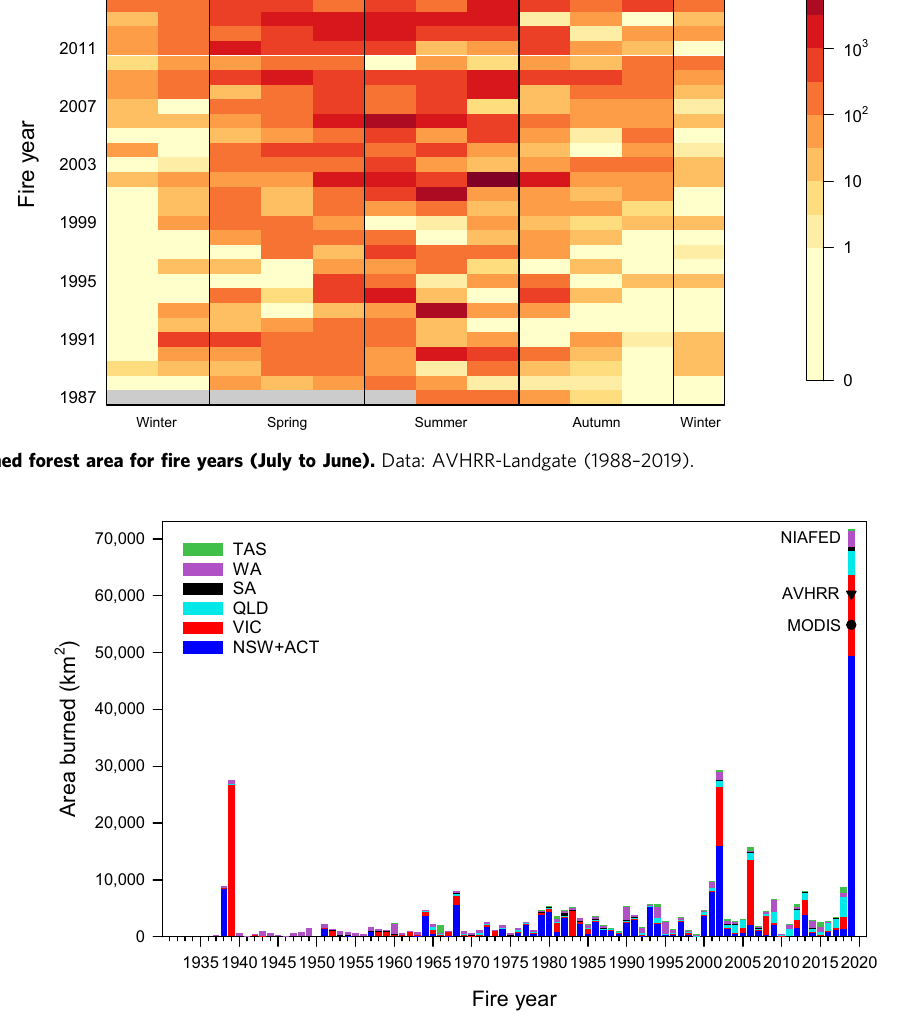
Fig. 3 Wild fi re burned area by states and territory in forest ecosystems for the 1930 to 2019 fi re years. New South Wales and Australian Capital Territory (dark blue), Victoria (red), Queensland (light blue), South Australia (black), Western Australia (violet) and Tasmania (green). Data for 1930 – 2018 stacked bars are State and Territory agencies fi re histories, supplemented with MODIS for Queensland in 2016 – 2018. Data for 2019 fi re year are National Indicative Aggregated Fire Extent Dataset (NIAFED) by States and Territories (stacked bar), AVRHRR-Landgate ( fi lled triangle), and MODIS ( fi lled circle). See “ Methods ” : Burned area